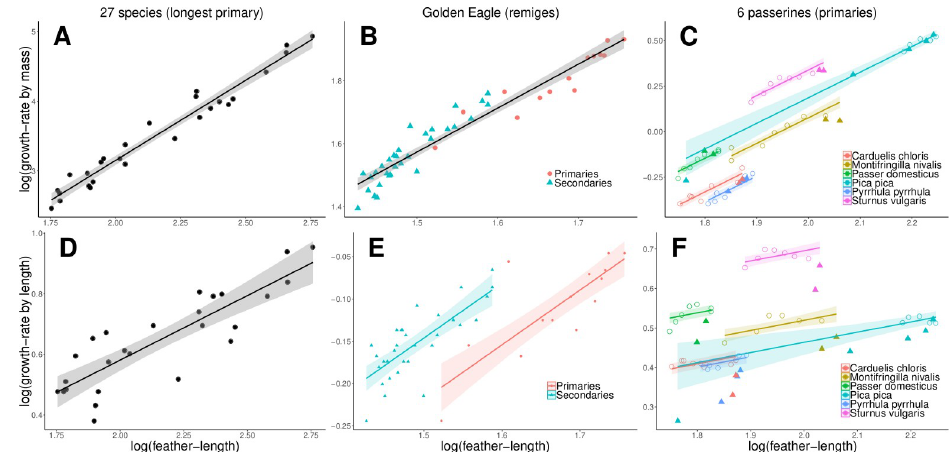
Fig 4. Feather growth-rate and feather-length. Relationships between feather growth-rates by mass (A-C), or alternatively growth-rate by length (D-F), and feather-length for three datasets: A and D: longest primary of 27 species, B and E: remiges of Golden Eagle (dots = primaries, triangles = secondaries), C and F: primaries of 6 passerine species (colours; filled triangles = ‘wing-tip primaries’, open circles = ‘proximal primaries‘). The lines indicate the regressions according to the analyses (see Table 2 and S2 Table, S4 Table and S6 Table): A, B, D: for the entire dataset; E: with a different intercept for primaries and secondaries; C and F: for the ‘proximal primaries’ only with a different intercept according to species. Golden Eagle growth-rate by length: Note that the outlier primary near the upper end of the regression line for secondaries is the only innermost primary analysed which is more similar in shape to the secondaries than the other